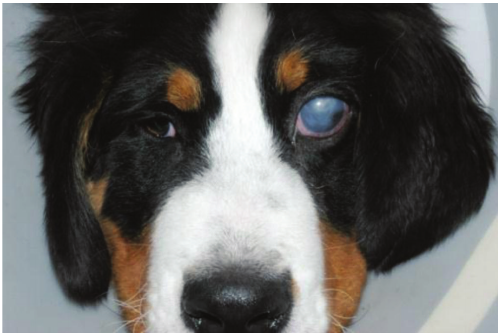
Figure 4: Closure of the sclera above the intraocular silicone prosthesis.